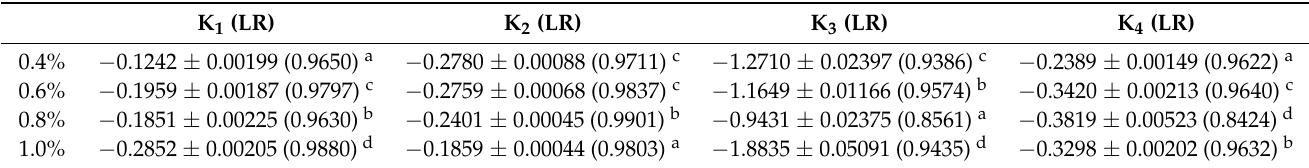
Table 4. The slopes of all D-f curves, including K 1 , K 2 , K 3 , and K 4